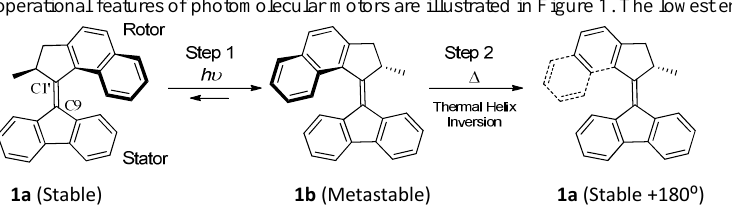
Figure 1 . Schematic representation of light abd thermally driven transitions between 1a and 1b states. ground state conformation ( 1a ) comprises a ‘stator’ linked via a double bonded ‘axle’ connected to a ‘rotor’, which has a chiral centre. The molecule is nonplanar due to steric strain. Excitation of the lowest energy p to p * transition localised on the axle reduces the bond order, releasing steric strain and hence a barrierless structural relaxation. The result of this excited state structure change is an isomerization reaction leading ultimately to population of the metastable ground state 1b with a yield of 5 – 20% depending on the substituents.[2] For these motors, and those which are symmetrically substituted on the fluorene ring, the conformation 1b can relax to 1a by a ground state thermal isomerization either in the reverse or the forward direction, but the forward helix inversion step is overwhelmingly favoured due to a lower energy barrier, leading to a half rotation